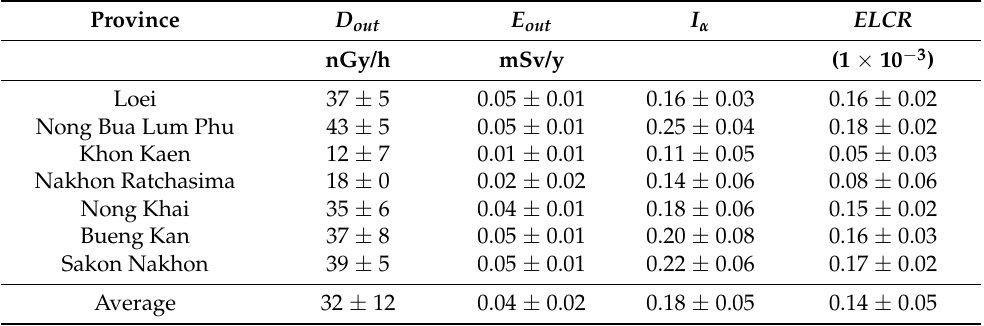
Table A1. The average D out , E out , I α , ELCR from sand samples collected from Loei, Nong Bua Lam Phu, Khon Kaen, Nakhon Ratchasima, Nong Khai, Bueng Kan, and Sakon Nakhon provinces in Northeastern Thailand. Assume that the sand is used outside residential